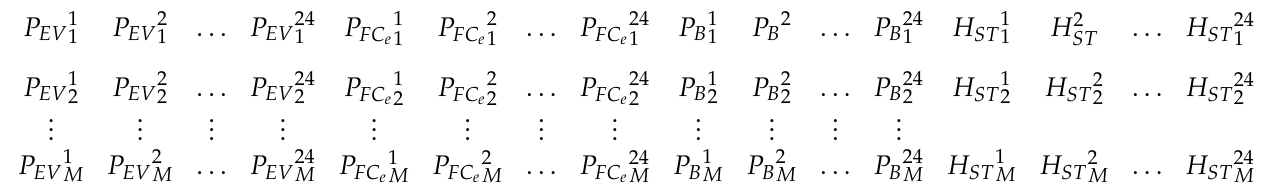
Figure 7. Chromosomes in one generation of the